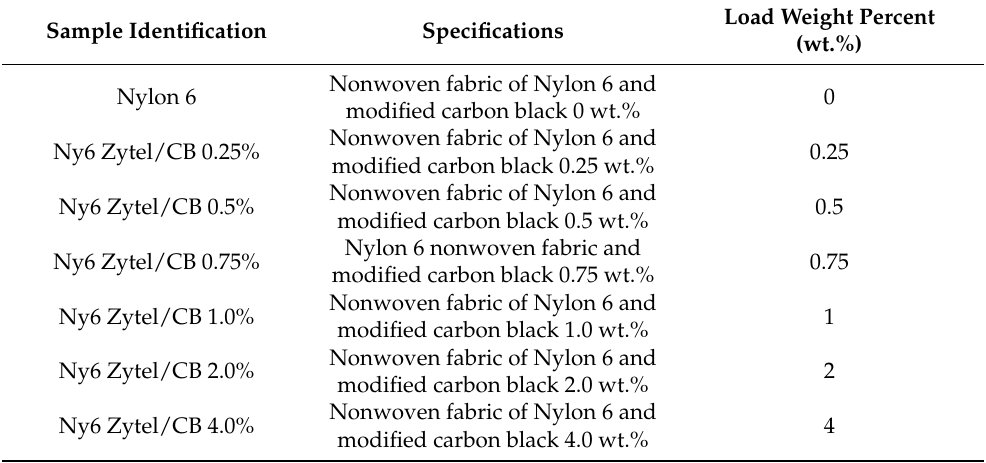
Table 1. Identification of